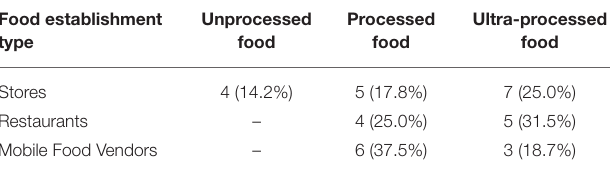
TABLE 6 | Percentage advertisements displayed according to category of processing of the food item on display across surveyed food establishments ( n = 60) of Delhi National Capital Region,